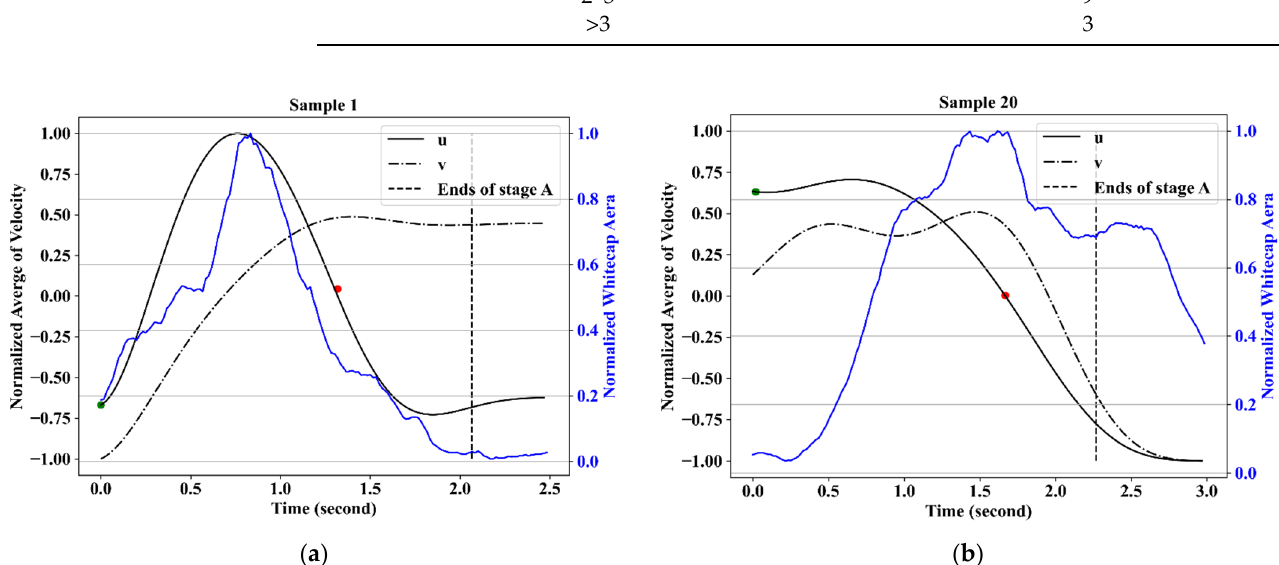
Figure 7. Time series of average u and v velocity of whitecap foam and normalized whitecap area. ( a , b ) are examples of the two types of velocity patterns as discussed in the text. The green dots denote the beginning of wave breaking according to IR images. The red dots denote the last time when the horizontal velocity changes direction. The vertical dash lines denote the end of stage A.